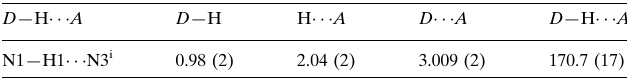
Hydrogen-bond geometry (A˚ , (cid:1)